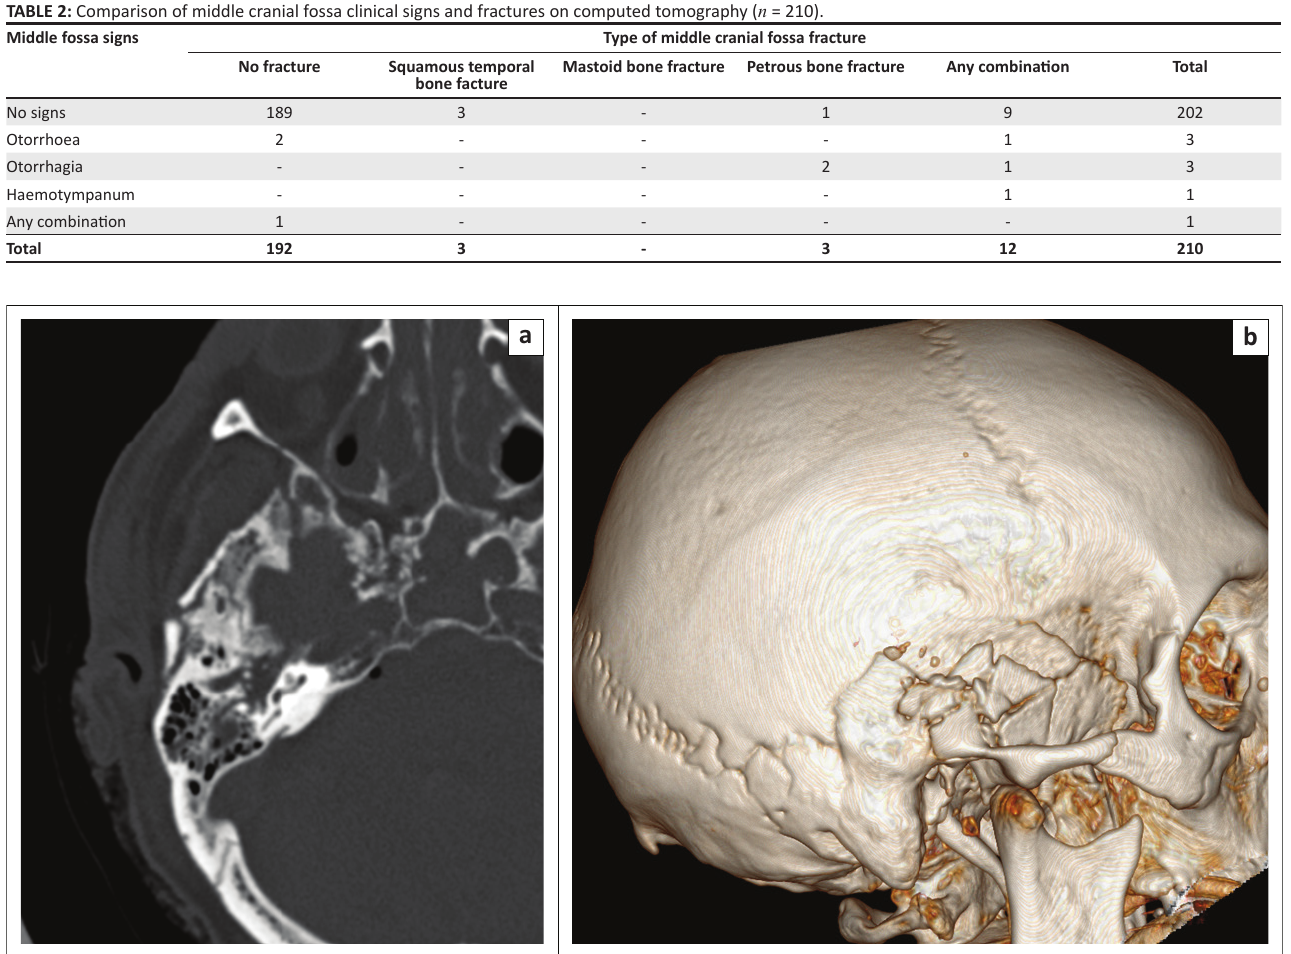
FIG URE 2: (a) Axial and (b) three-dimensional image of a complex petrous temporal bone fracture in combination with a comminuted, squamous temporal bone fracture.